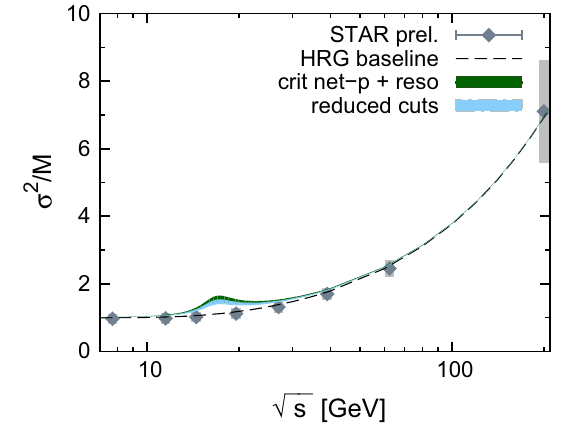
√ Fig. 4 Cumulant ratio σ 2 / M as a function of s including resonance decays and critical fluctuation contributions for g p = 5 ( both filled bands ). As in Fig. 3, for g R = 0 the results are closest to the non- critical baseline ( thin dashed curve ). For guidance, we also show the preliminary data [23]. Reducing the kinematic acceptance, for example by decreasing the value for k max from 2 GeV ( upper band ) to 0.8 GeV T ( lower band ), reduces the non-monotonic behavior caused by critical fluctuations